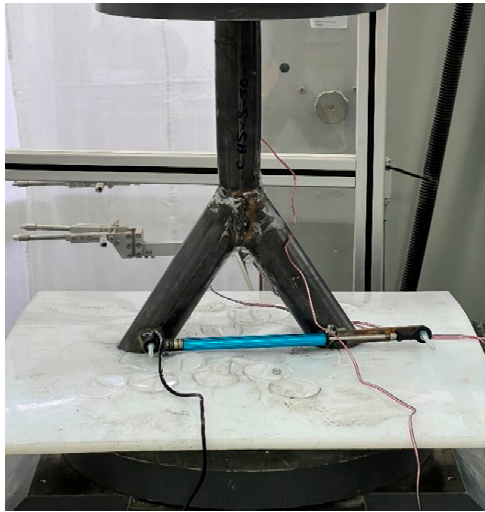
Figure 2. Laboratory test setup—onsite.